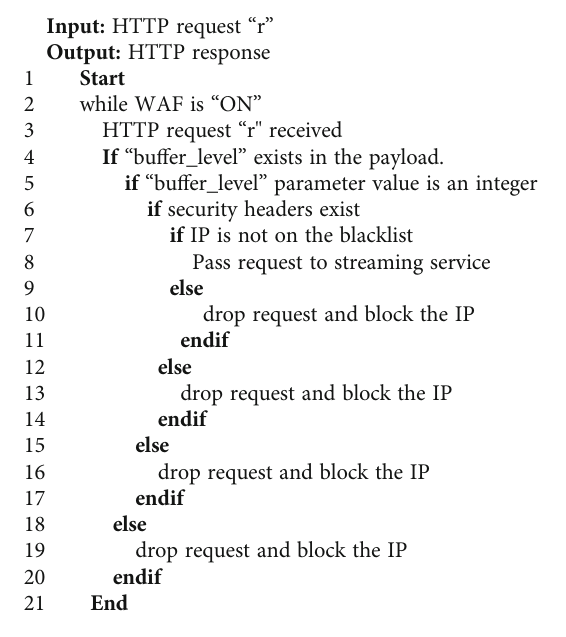
Algorithm 2: Light WAF